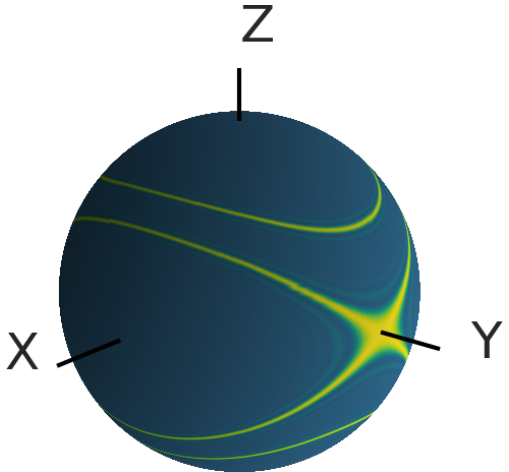
Figure 9. The orientations (shown in yellow) of the transient triplet label that are excited by a rectangular π pulse with a pulse length of 20ns that is placed on the Y + peak of EPR spectrum of TPP in Q-band. For the calculation, the magnetic field was set to B = 1 . 2097T, and the pulse frequency was set to 33 . 646GHz. The po- sition of the pulse relative to the EPR spectrum is shown in Fig. S7. The angle β T is the polar angle of the depicted sphere, and the angle γ T is the azimuthal